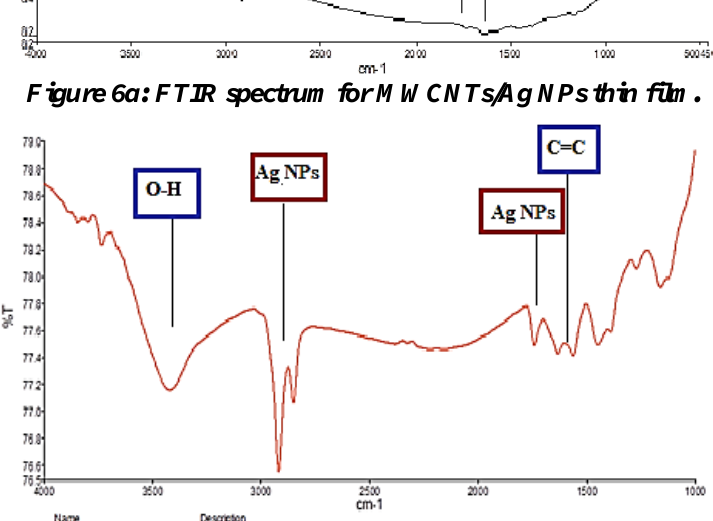
Figure 6b: FTIR spectrum for SWCNTs/Ag NPs thin film.